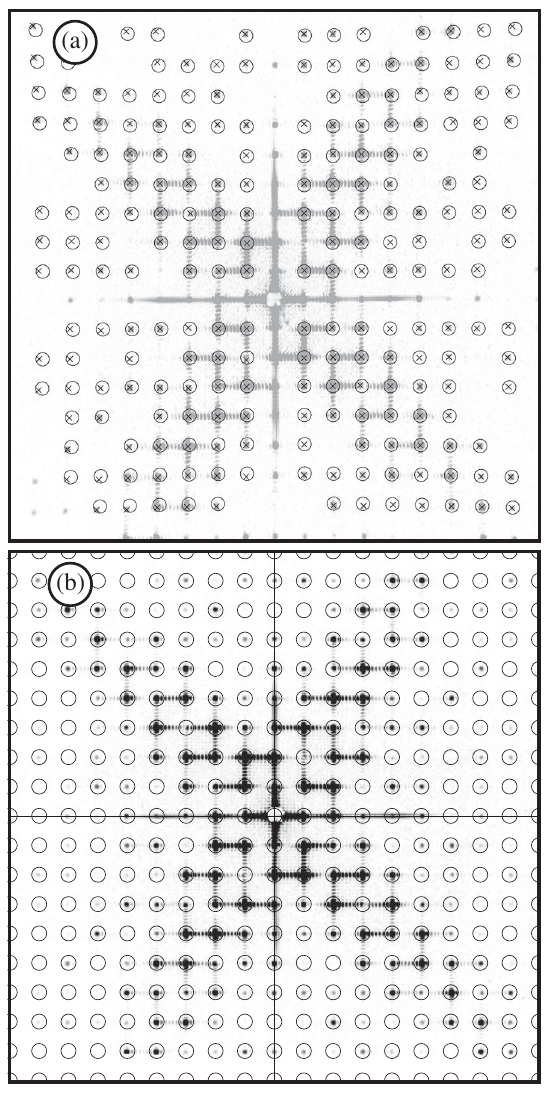
FIG. 4. Comparison between found and predicted Bragg peaks (a) and remapped diffraction intensities projected onto a plane in reciprocal space, after correcting minor distortions caused by the 45° mirror (b). The majority of remapped patterns appeared qualitatively similar to this one, with peaks well centered within the predicted